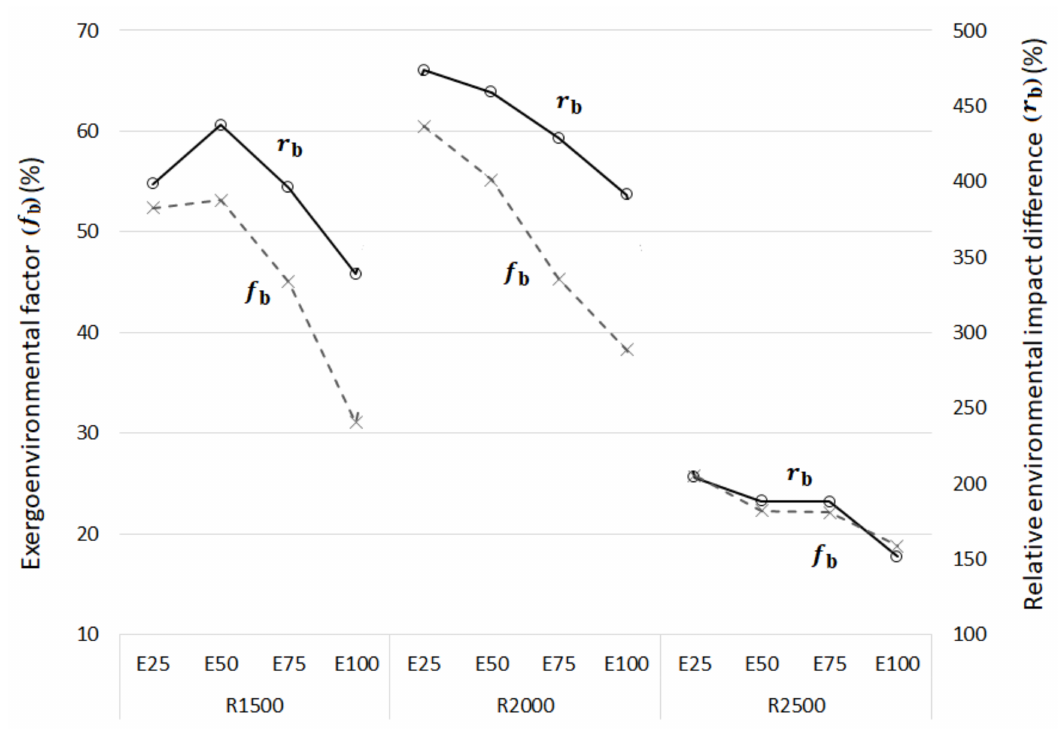
Figure 6. Exergoenvironmental factors and relative differences in environmental impact vs. ethanol